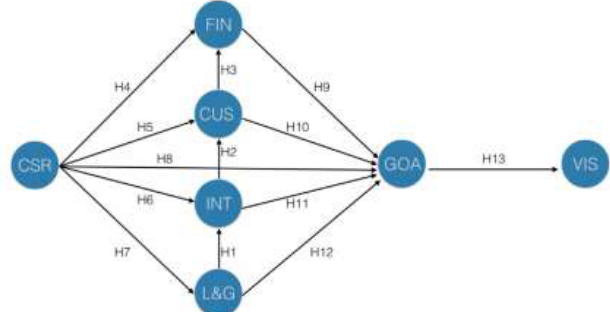
Fig. 7. Proposed model for managers ( Source: Author’s compilation )